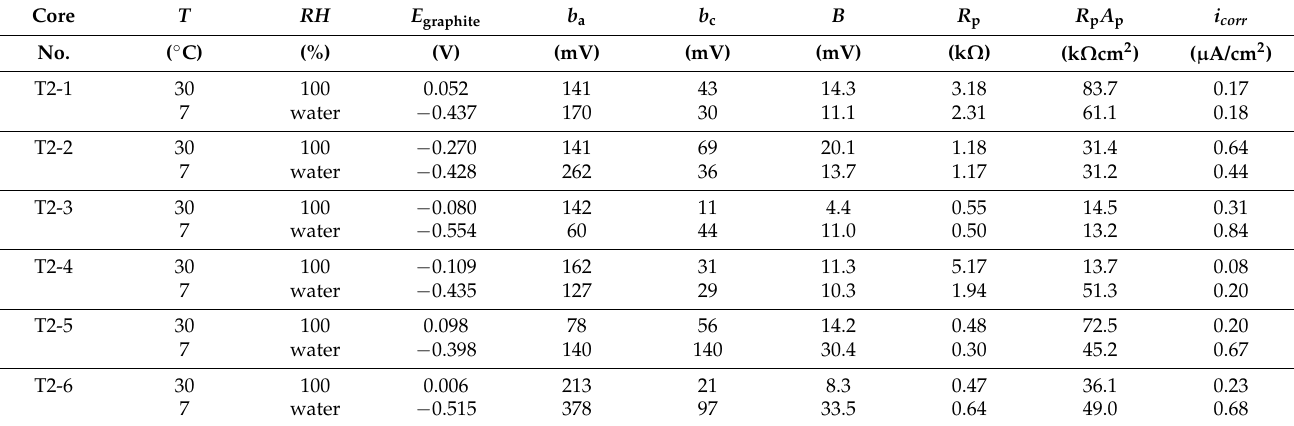
Table A2. Results of the analysis of polarization curves for steel reinforcement in cores drilled from the tank